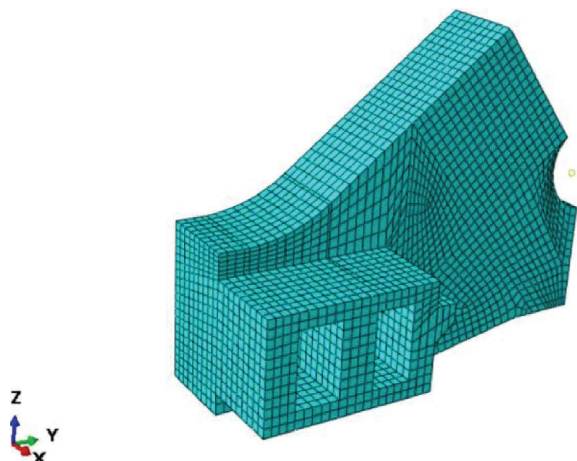
Figure 4: Grid division of concrete